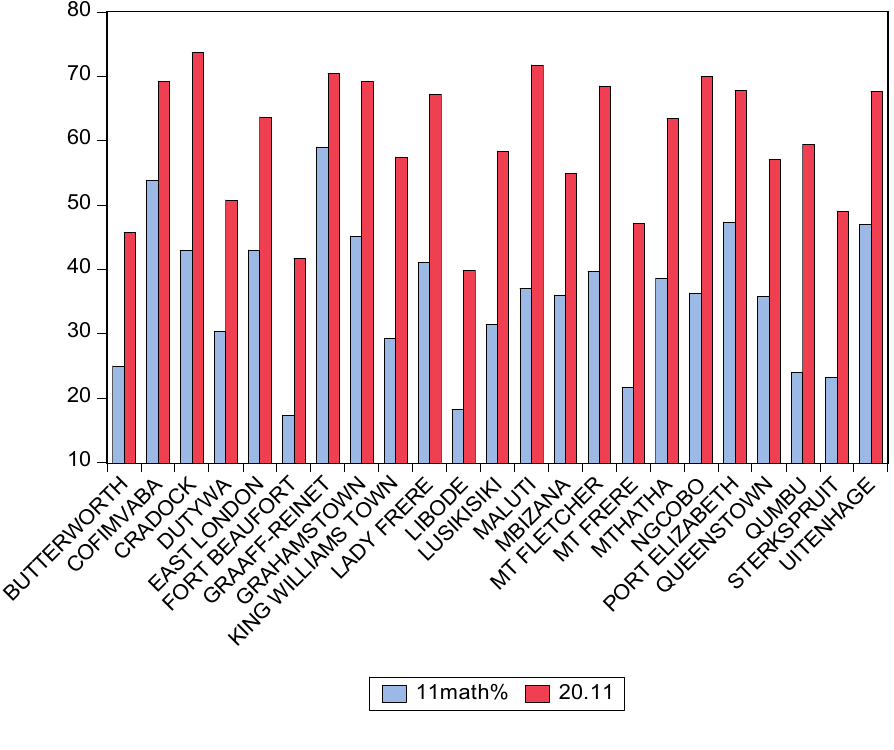
Figure 4: Grade 12 and Mathematics pass rate at district level,